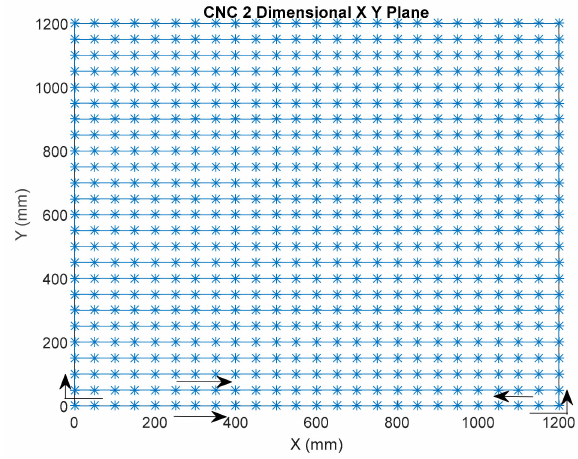
Figure 8. Traverse path of the target object equipped with microphone receiver in the CNC’s 2- dimensional XY plane. The asterisks show the test points where the data were